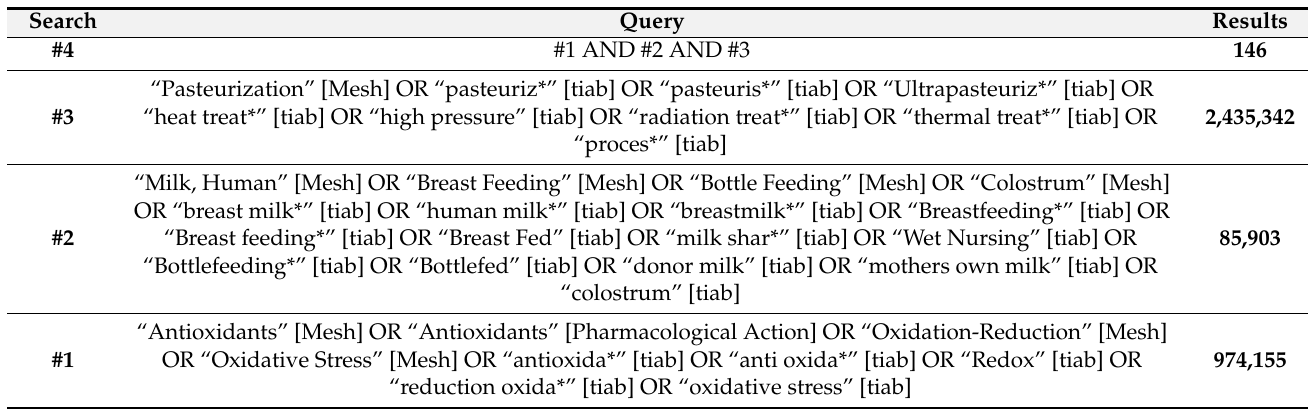
Table A1. Search strategy in PubMed.